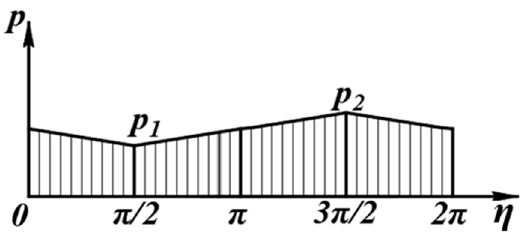
Figure 5. Initial shield shell force distribution curve.